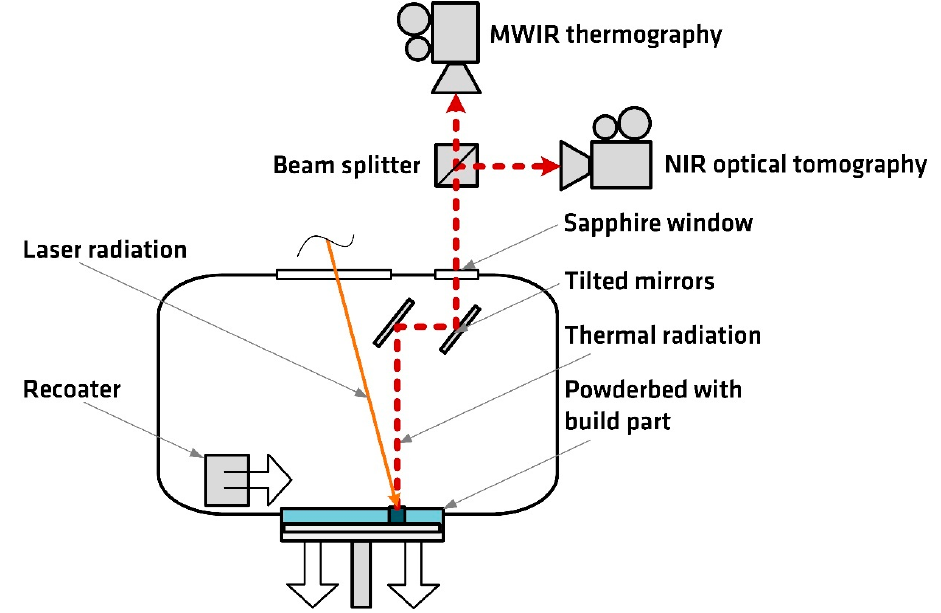
Figure 3. Schematic of the off-axis camera setup.